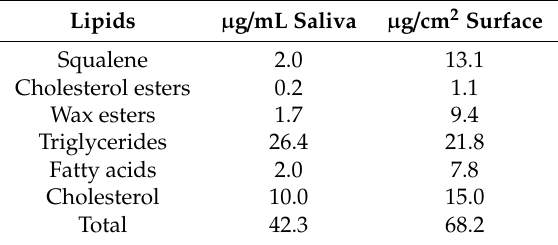
Table 1. Composition of neutral lipids from saliva [15] and the mucosal surface [31]. These unpublished data are used with permission from Dr. Philip Wertz. Lipid samples from the mucosal surface were obtained using Whatman filter paper held against the cheek for one approximately minute. Squalene and wax esters are biochemical markers of human